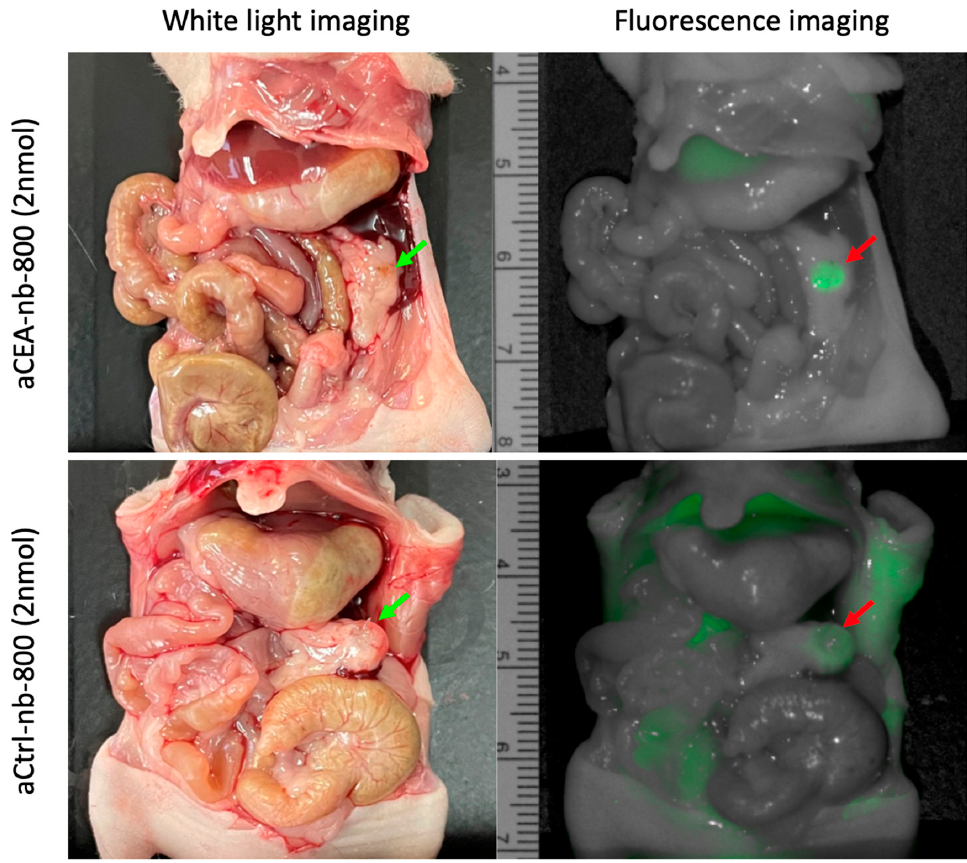
Figure 2. Pancreatic cancer patient-derived orthotopic xenograft (PDOX) mouse models labeled with either aCEA-nb-800 ( top panels) or aCtrl-nb-800 ( bottom panels). Mean MFI from the tumor using aCEA-nb-800 was 1.9 a.u. with a background MFI of 0.86 and a TBR of 2.2. Mean MFI from the tumor using aCtrl-nb-800 was 0.70 a.u. with a background MFI of 0.52 and a TBR of 1.3. The pancreatic PDOX tumor was bivalved and a tissue section was further imaged ex-vivo using the LICOR-Odyssey (Figure 3). Images of the tumors labeled with aCEA-nb-800 and aCtrl-nb-800 were obtained under white light and fluorescence, and a pseudo-color intensity map was constructed. The fluorescence signal was localized at the tumor and did not show a signal from the surrounding pancreatic parenchyma. Under magnification, the tumor showed a TBR of 11.97 at the tumor using aCEA-nb-800 and a TBR of 2.97 using the aCtrl-nb-800 (Figure 3).